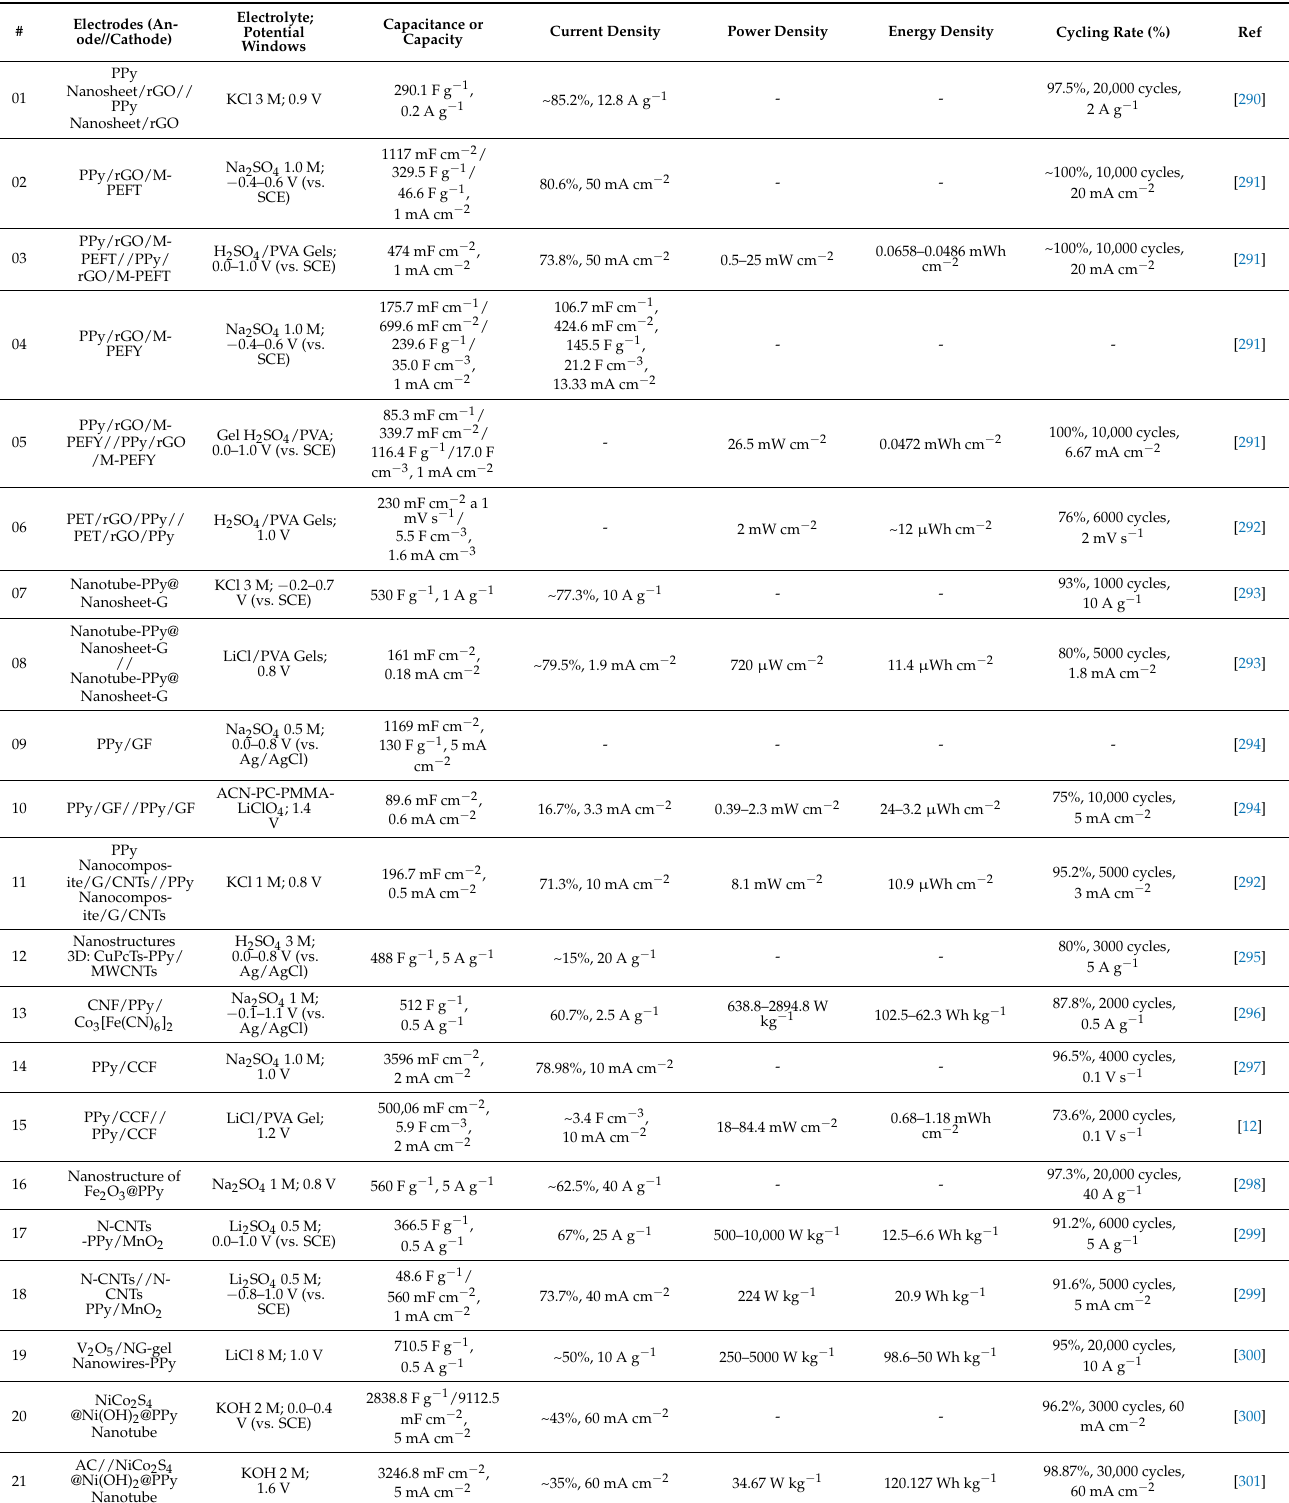
Table 3. Nanostructured PPy in various configurations, evaluated for supercapacitor electrodes, with their performance